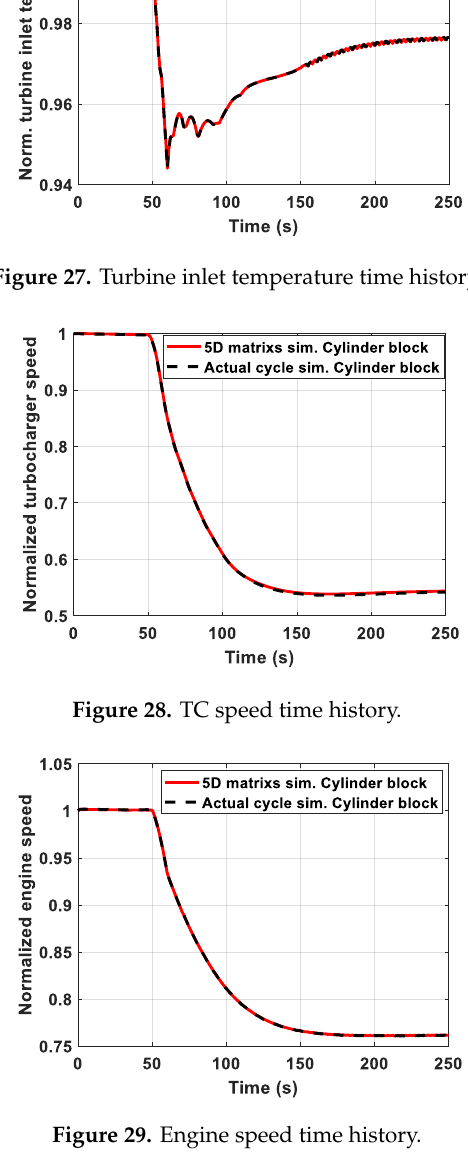
Figure 30. Propeller thrust time history.